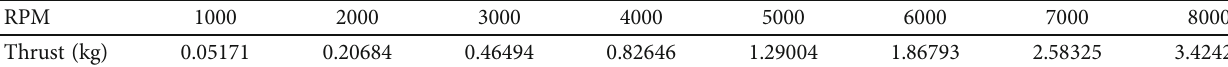
Table 2: The APC nylon propeller 1485E static thrust at various RPM.